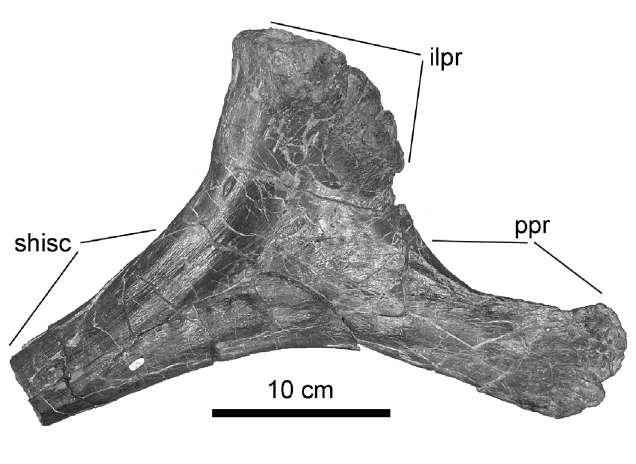
Figure 19. Right ischium, lateral view. Vagaceratops irvinensis , CMN